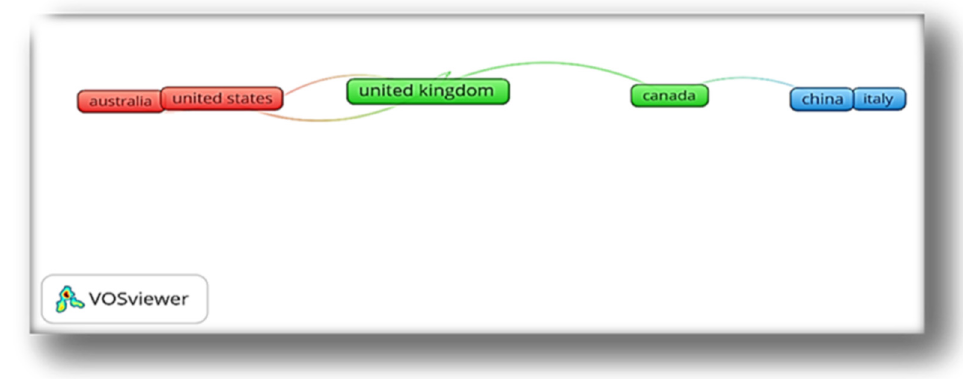
Figure 5. Country-level Collaboration Map of Countries